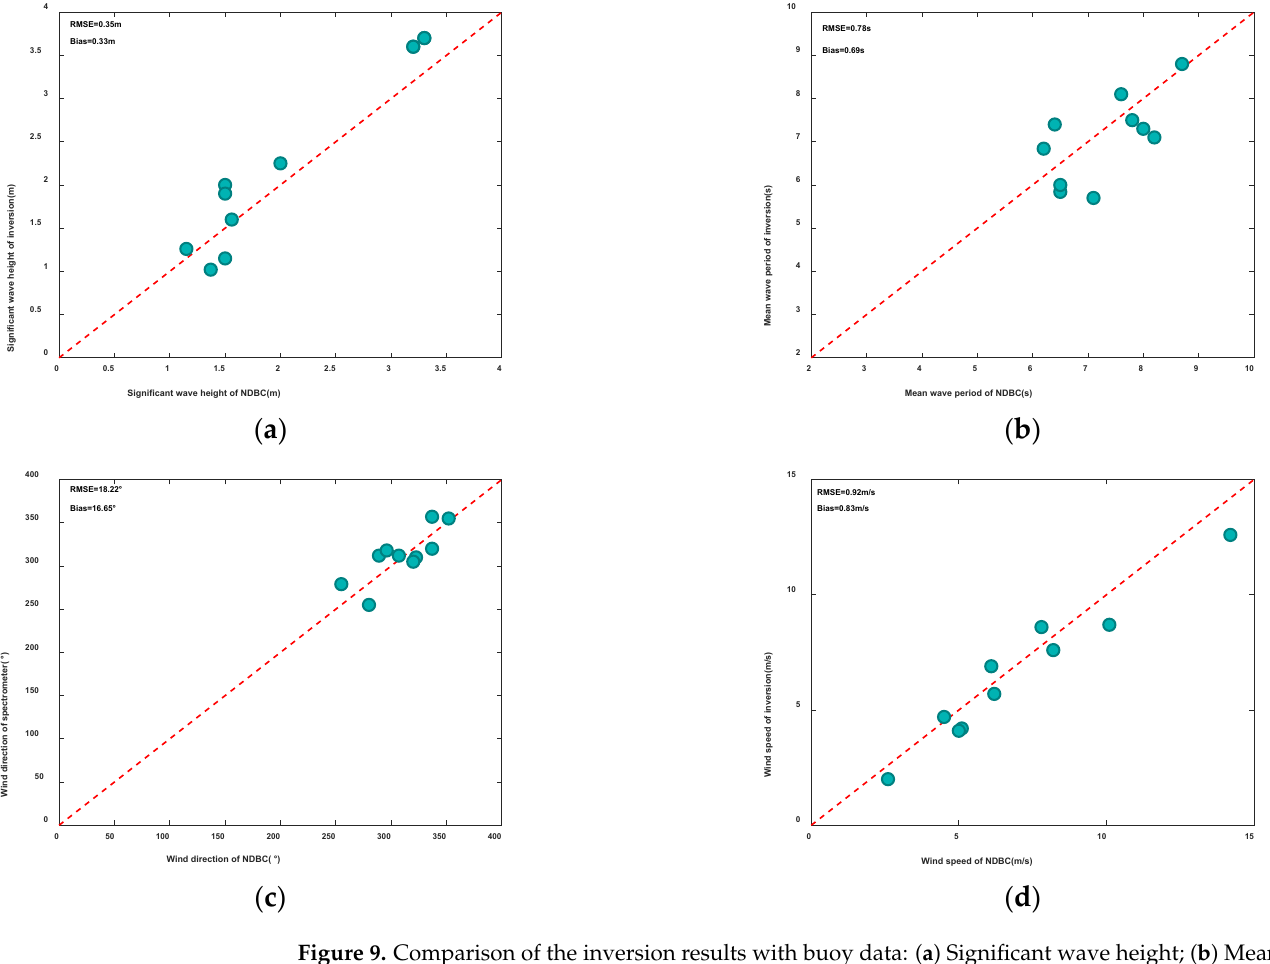
13 of 16 Figure 8. Comparison of the inversion results with the ECMWF ERA5 data: ( a ) Significant wave height; ( b ) Mean wave period ( c ) Wind direction; ( d ) Wind speed. 3.2. Comparison of Joint Inversion Results with Buoy Data This section uses 10 sets of the collocated Sentinel-1 SAR WV mode and SWIM data, and the 10 scenes data were matched with buoy data, respectively, to verify the accuracy of the joint inversion results. The RMSE and Bias were also used to evaluate the accuracy